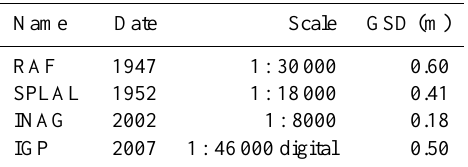
Table 1. Aerial photographs used in this study. GSD is the ground sample distance (pixel size) after scanning the analogue images with a photogrammetric